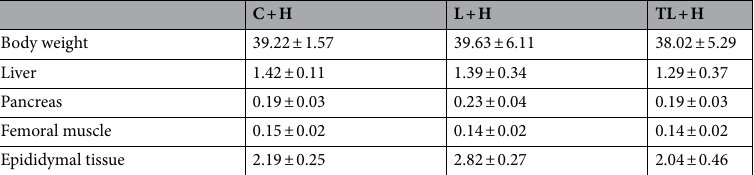
Table 1. Analyses of tissues from mice of different treatment groups. C + H control + HFD, L + H L-NAME + HFD, TL + H L-NAME + tadalafil + HFD, L-NAME L-NG-nitroarginine methyl ester, HFD high-fat